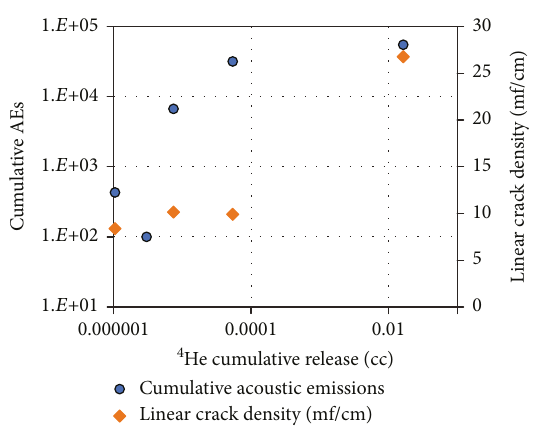
Figure 8: Cumulative helium release plotted versus cumulative acoustic emissions and linear crack